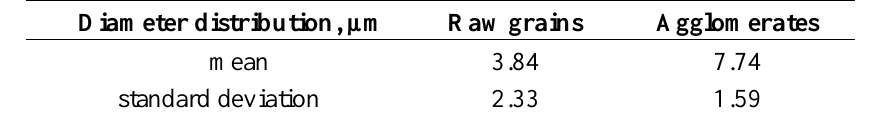
Table 3. Size distribution of the cement